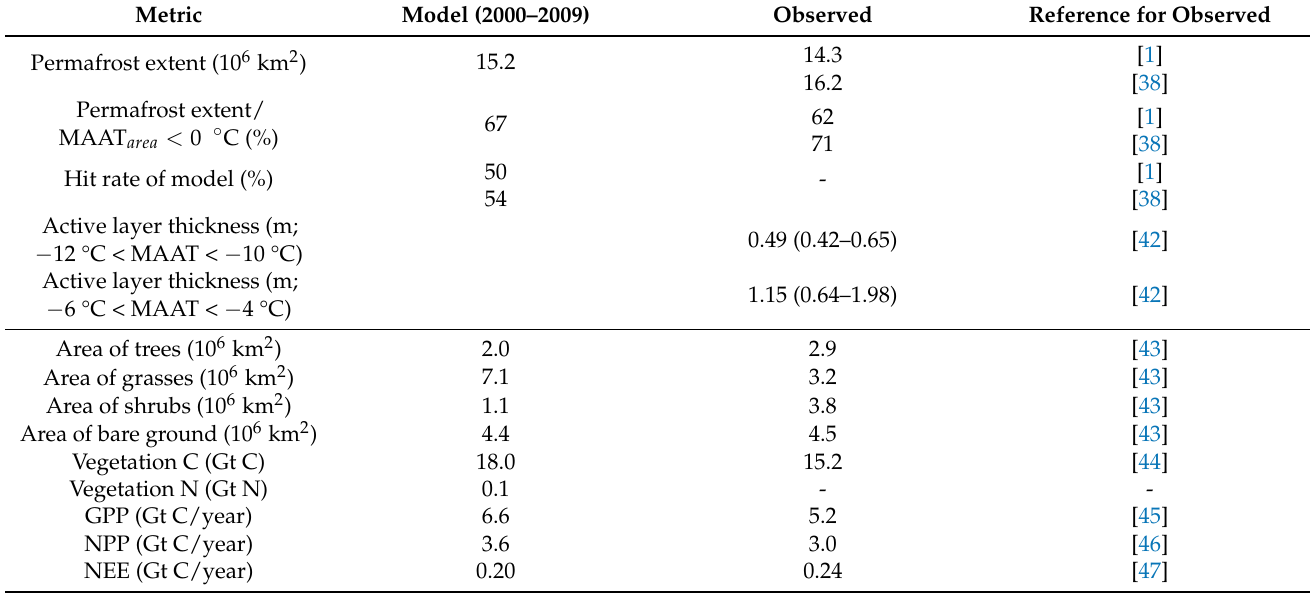
Figure 1. Permafrost extent ( a ) simulated by CN spun model configuration for the period 2000– 2009 and ( b ) from the observations provided by [1]. The model assumes either no permafrost or 100% permafrost, whereas the observations capture subgrid scale heterogeneity and therefore give the proportion of permafrost in each grid cell. Superimposed in yellow on each plot is the zero °C annual mean isotherm from the WFDEI 2000–2009 2 m air temperature [39]. Table 3. Evaluation metrics for CN spun using the transient-ens, based on model simulations of permafrost extent, and vegetation and soil attributes. The carbon and nitrogen cycle metrics (“Area of trees” and below) are derived only for the grid cells where the model simulates permafrost for the period 2000–2009. Soil organic C and inorganic N contents are defined over the top 3 m and the soil organic N is defined for the top 1 m of soil ∗ . GPP stands for gross primary productivity, NPP for net primary productivity and NEE for net ecosystem exchange with positive reflecting net uptake at the land surface. Ecosystem turnover is defined as (vegetation C + soil C)/GPP and soil turnover is defined as soil C/NPP. The response ratio a is the ratio of the potential amount of C that can be allocated to growth and spreading of the vegetation when the nitrogen is freely available compared with the actual amount achieved in the natural state when N may be limited. It is calculated from the multi-annual means of all the grid cells in the respective biomes. The boreal and tundra biomes in the model were characterised by [40] based on the World Wildlife Fund terrestrial ecoregions